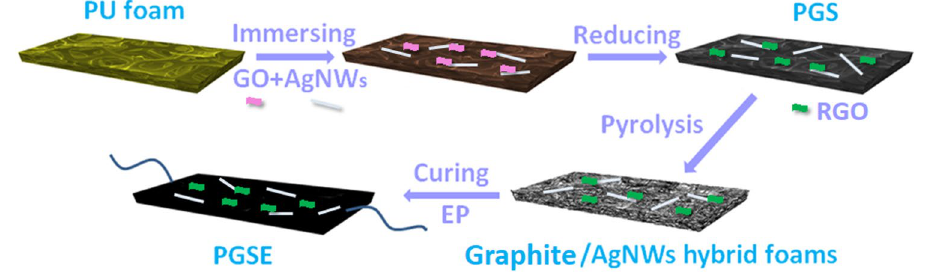
Figure 1. Overall fabrication process of the PGSE composites, including: 1) Immersion of a commercial PU foam into the mixture of AgNWs, GO, and Vitamin C; 2) Assembly of graphite and AgNWs on the PU skeleton by in-situ chemical reduction of GO; 3) Pyrolysis of the PGS to obtain graphite/AgNWs hybrid foams; 4) Immersion of graphite/AgNWs hybrid foams into the epoxy resin and curing.